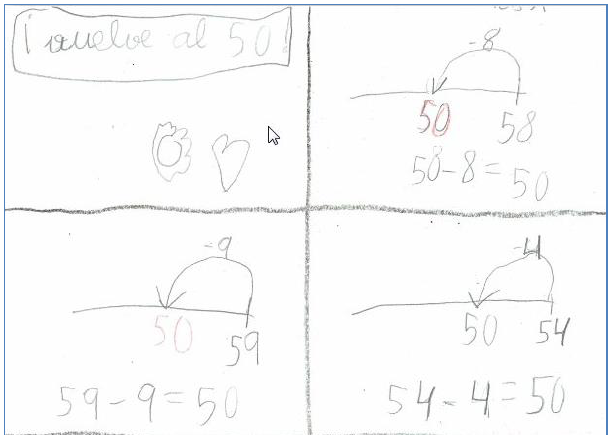
Figure 9. Return to the previous ten.